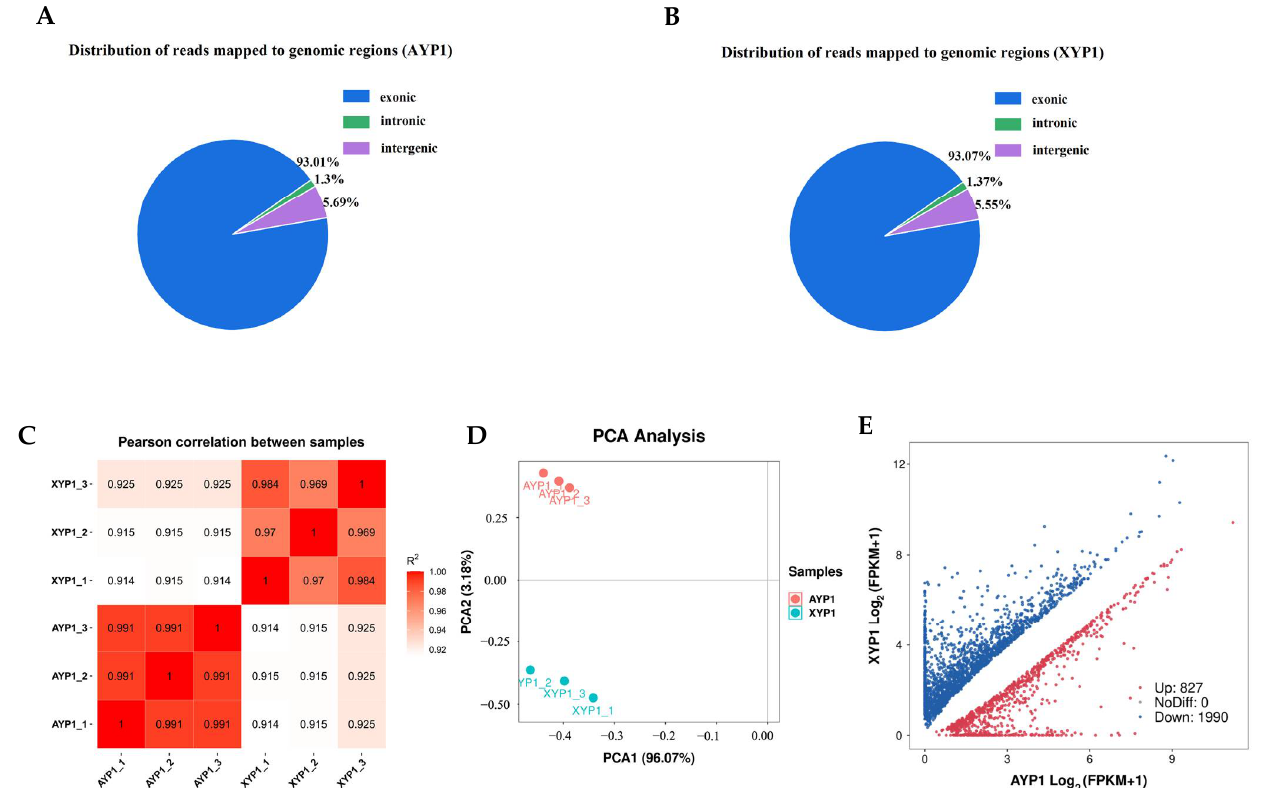
Figure 3. The results of reads mapping ( A , B ), the correlation analysis of six samples ( C ), the PCA analysis of six samples ( D ), and the differentially expressed genes between two parents ( E ). Table 2. The statistics of mapping results for RNA-Seq.